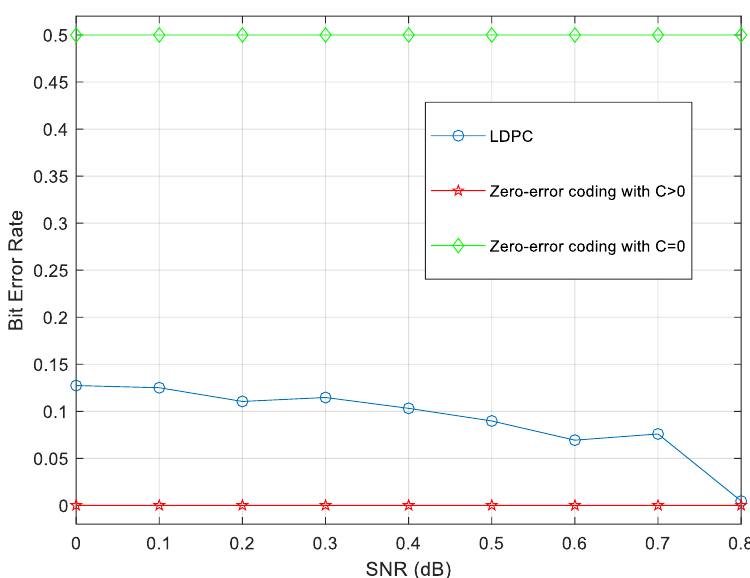
Figure 8. BER vs SNR in LDPC and zero-error coding cases according to channel capacity C.